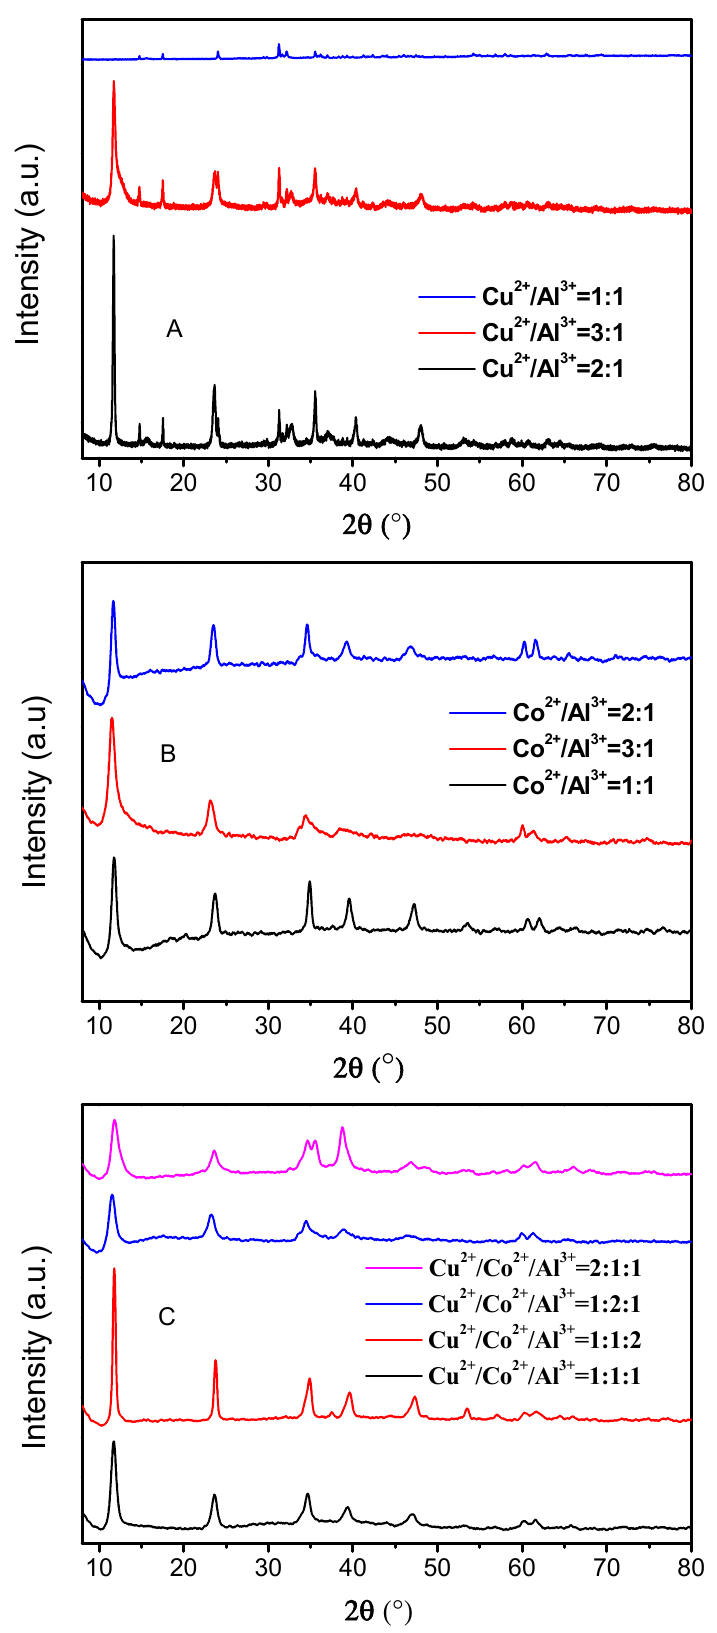
Figure 1. XRD patterns of the prepared HTLCs: ( A ) Cu/Al–HTLCs; ( B ) Co/Al–HTLCs; ( C ) Cu/Co/Al–HTLCs.